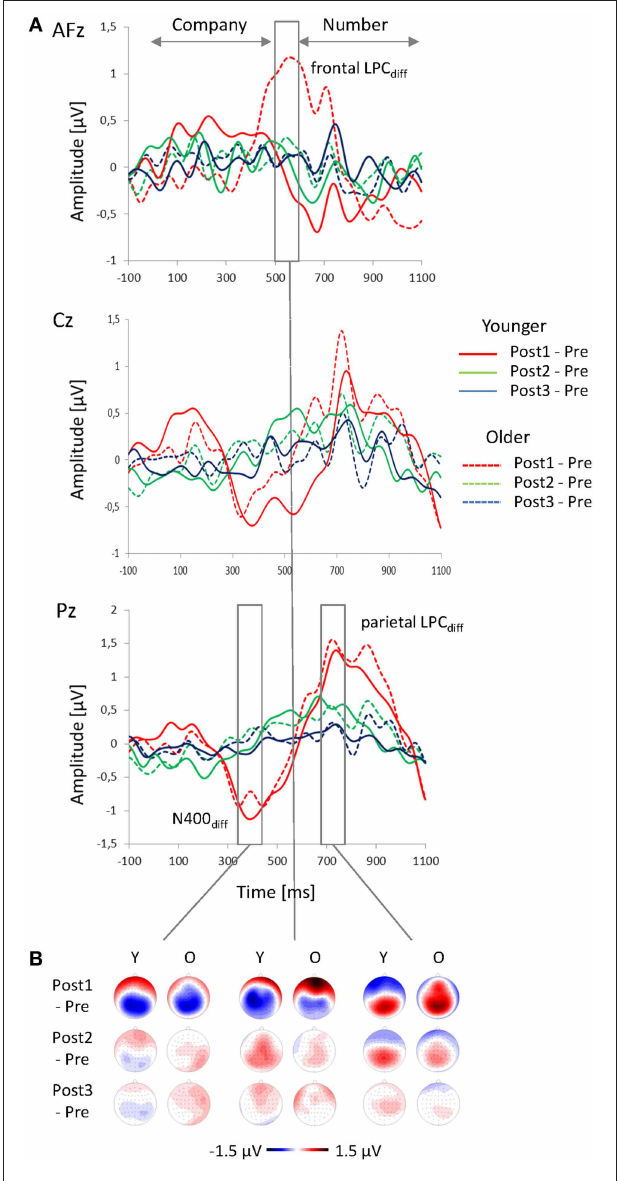
FIGURE 5 | Change-related ERPs. (A) Difference waveforms (Post minus Pre) at AFz, Cz, and Pz plotted as a function of time relative to the speech onset and (B) topographies of the change-related ERPs (N400 diff , frontal and parietal LPC diff ) for Post1, Post2, and Post3 sequences, shown for younger and older participants.